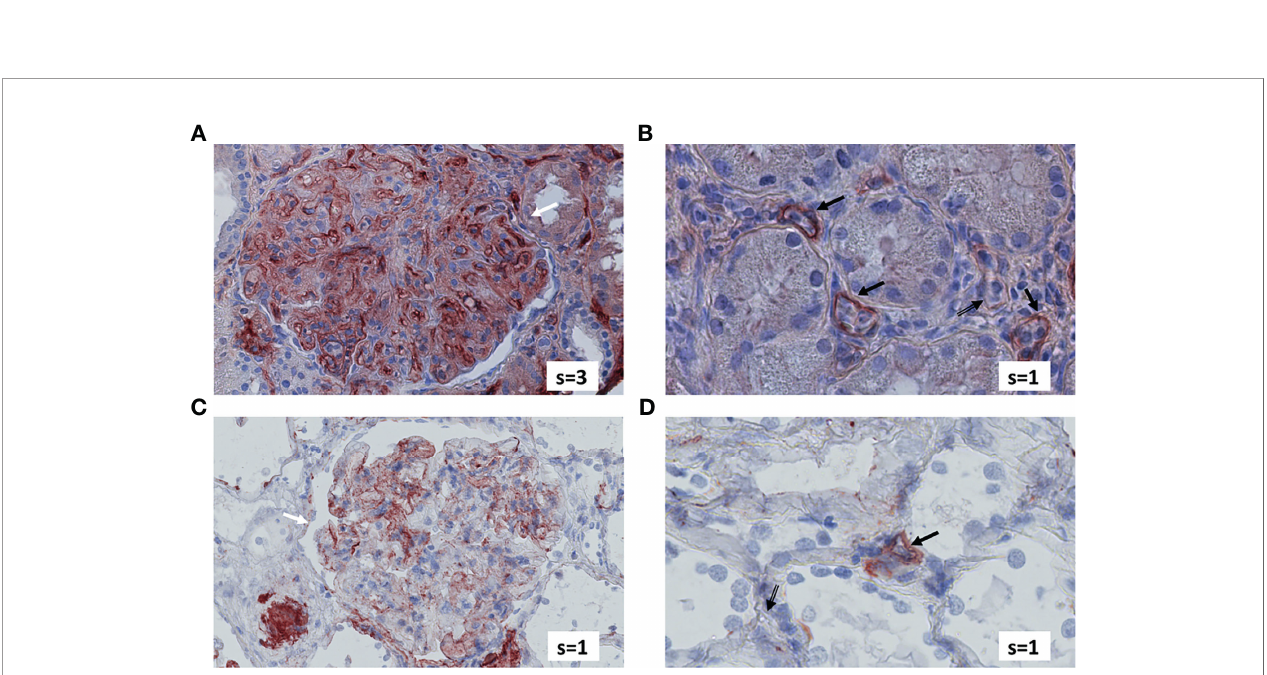
FIGURE 4 | Renal biopsy staining for complement factors in a KTR diagnosed with C4d-positive, aABMR. Selected section of biopsy slide stained for C3d in glomeruli (A) and in peritubular capillaries (B) . Selected section of biopsy slide stained for C5b-9 in glomeruli (C) and in peritubular capillaries (D) . White arrows indicate glomeruli and black arrows indicate peritubular capillaries. Double-compound arrows indicate C5b-9 negative peritubular capillaries (D) . Semi- quantitative scores (0-4) are indicated in the lower right corner of each picture. KTR, kidney transplant recipients; aABMR, active antibody-mediated rejection; s, semi-quantitative